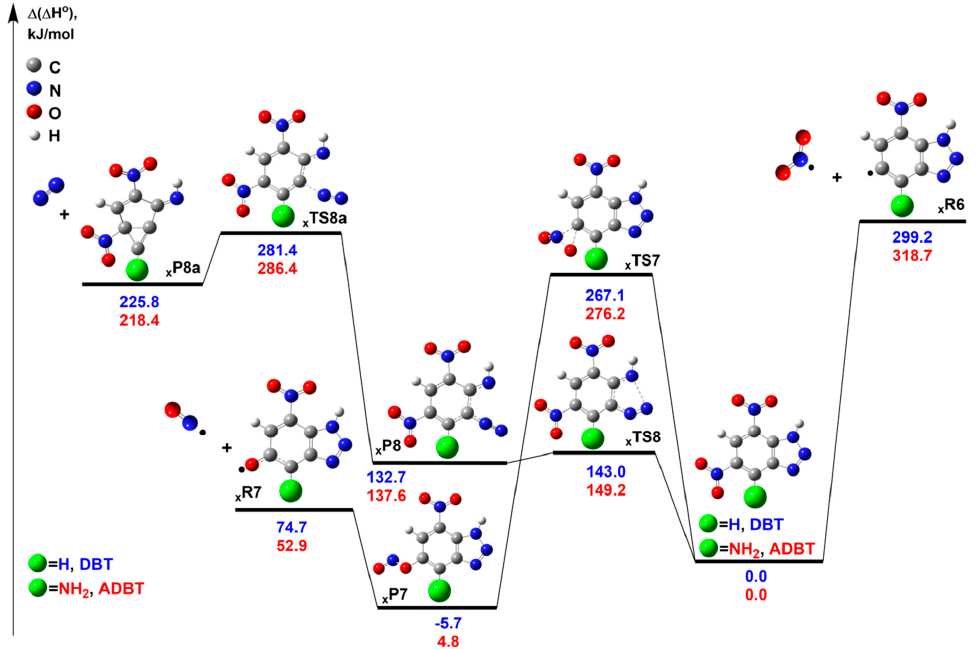
Figure 9. The relevant stationary points on the PES corresponding to the suggested decomposition pathways of DBT and ADBT . DBT and ADBT are used as the reference compounds for the calcu- lation of the relative enthalpies at 298 K ( Δ ( Δ H °)). The most favorable decomposition channels are shown for the reactions x R6 and x TS7 . The geometry optimization and calculation of the thermal corrections were performed at the M06-2X/6-311++G(2df,p) level of theory, and the single point en- ergies were computed at the DLPNO-CCSD(T)/jun-VQZ level. All energy values are given in kJ mol − 1 .